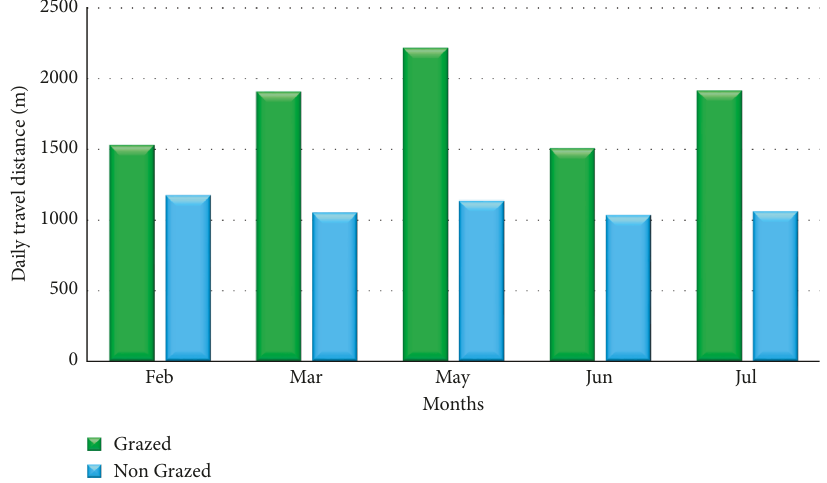
Figure 6: Monthly mean of daily travel distances (m) for the study group across grazing